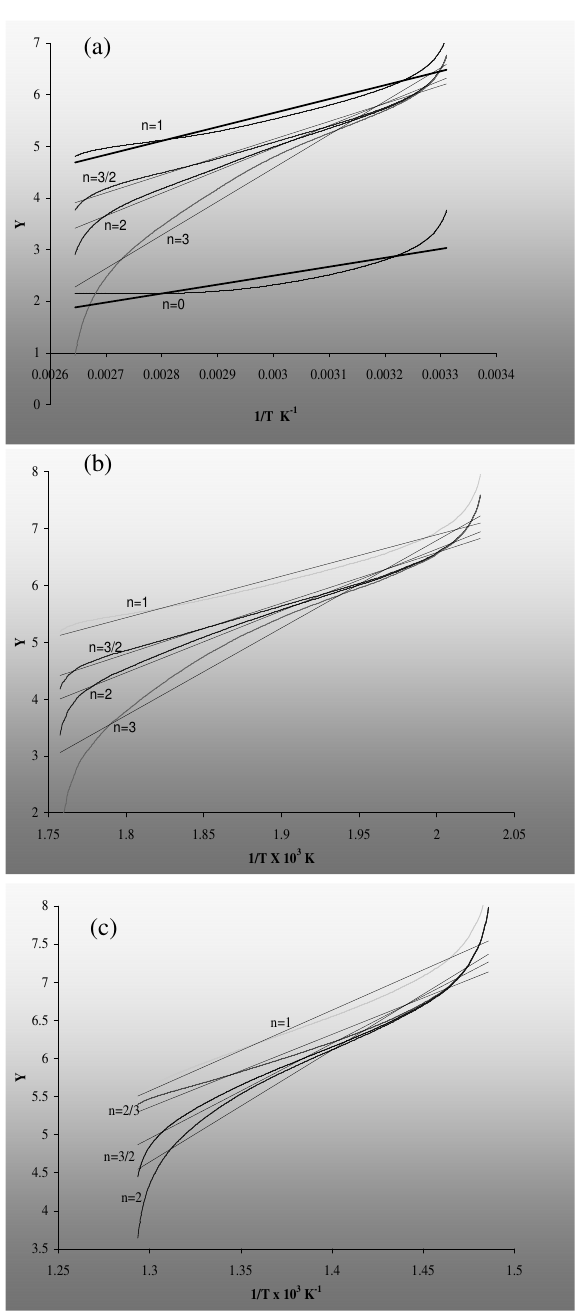
Figure 4. Plots of Coats and Redfern Method (a) Step I, (b) Step II, (c) Step